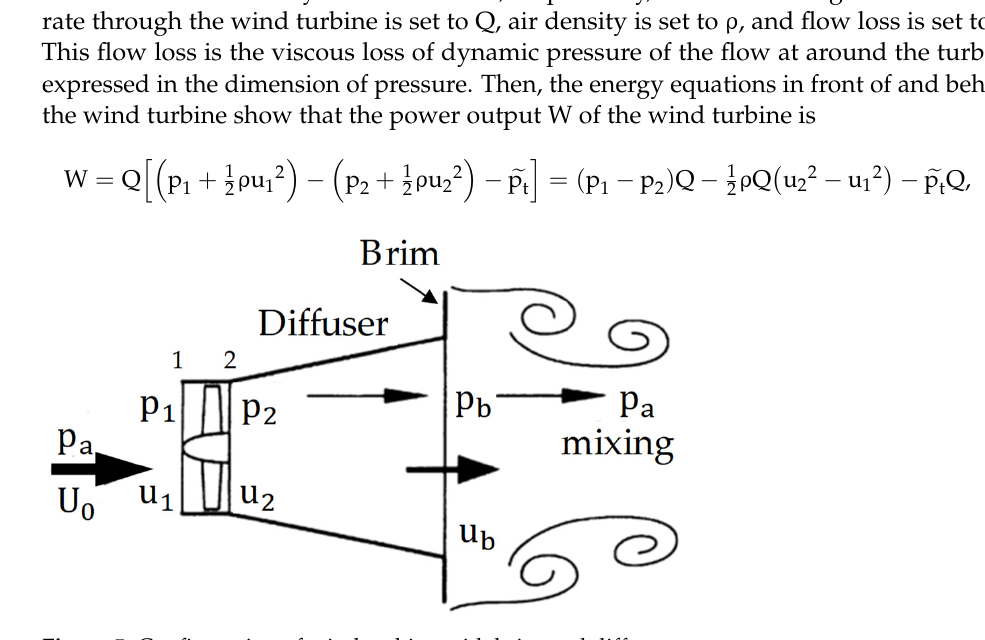
Figure 4. Field experiment of a 100 kW wind lens turbine (WLT) with a rotor diameter of 12.8 m and a lens diameter of 15.4 m. Adapted from ref. [20].